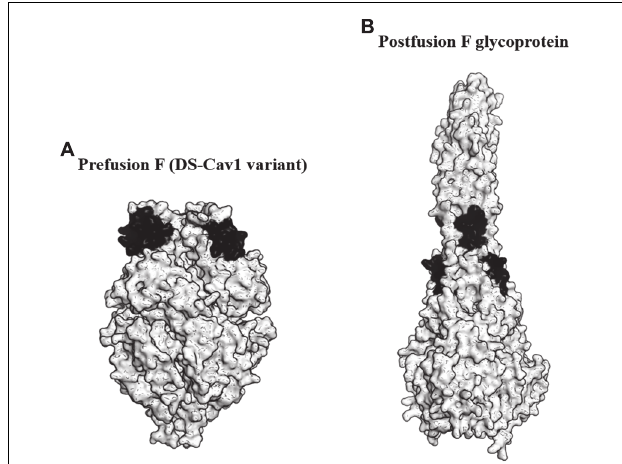
FIGURE 2 | Targeting the prefusion F glycoprotein of respiratory syncytial virus (RSV). (A) Surface representation of the DS-Cav1 F glycoprotein variant (PDB ID: 4MMU). DS-Cav1 adopted the prefusion F glycoprotein conformation. The antigenic